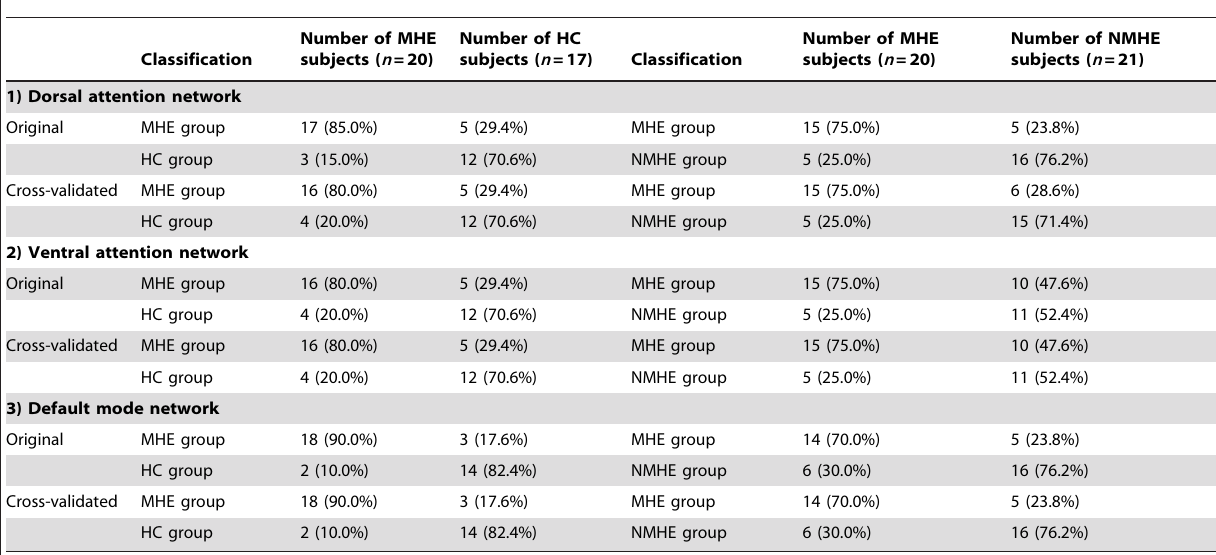
Table 4. Results of linear discriminant analysis between MHE patients and NMHE patients or between MHE patients and HC, with the functional connectivity strength of ROIs from single attention-related networks as